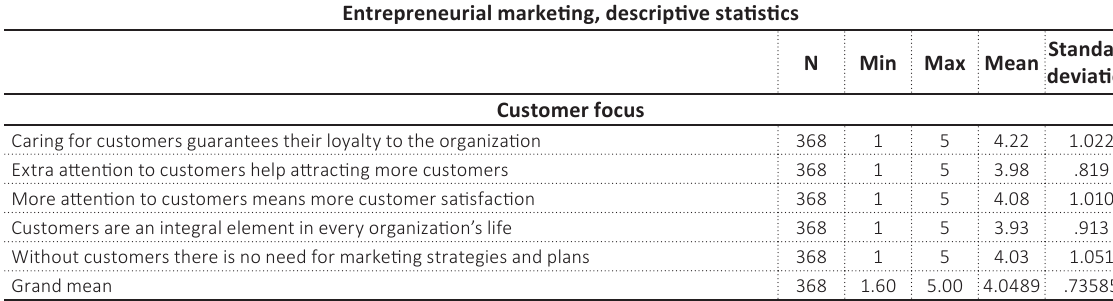
Table 2. Questionnaire